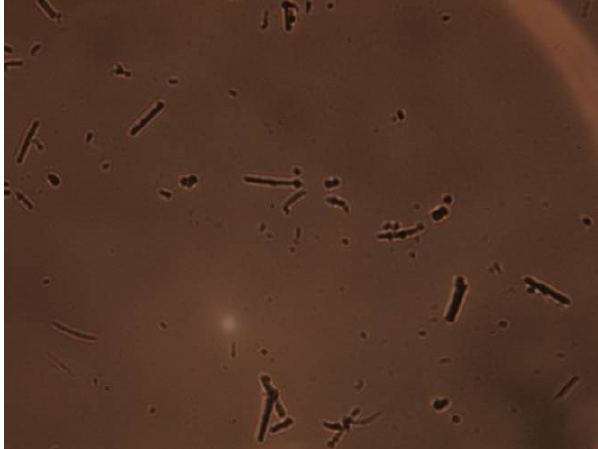
Fig. 3. Example photograph of the glass fibres collected on